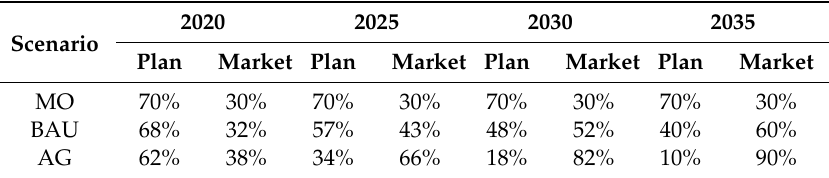
Table 1. The shares of planned generation and market generation under the moderate (MO), business as usual (BAU and aggressive (AG) electricity marketization scenarios.